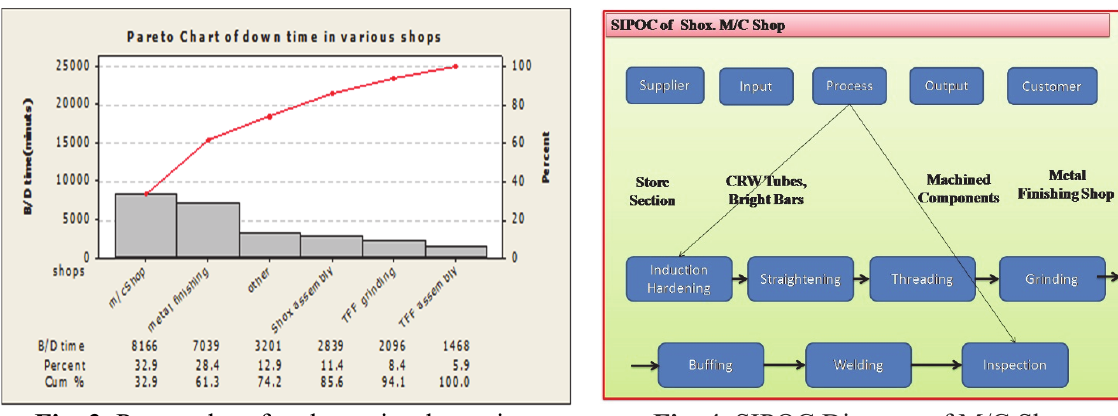
Fig. 2. Major Reasons for Capacity Waste